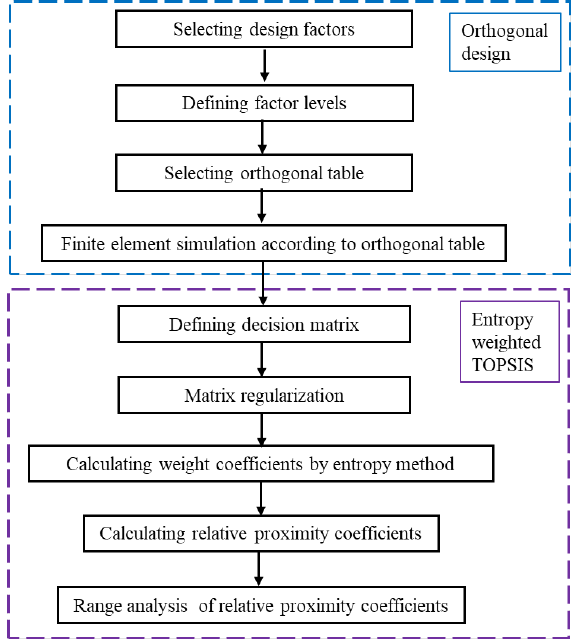
Figure 11. Flowchart of crashworthiness analysis of CFRP-Al hybrid tubes.